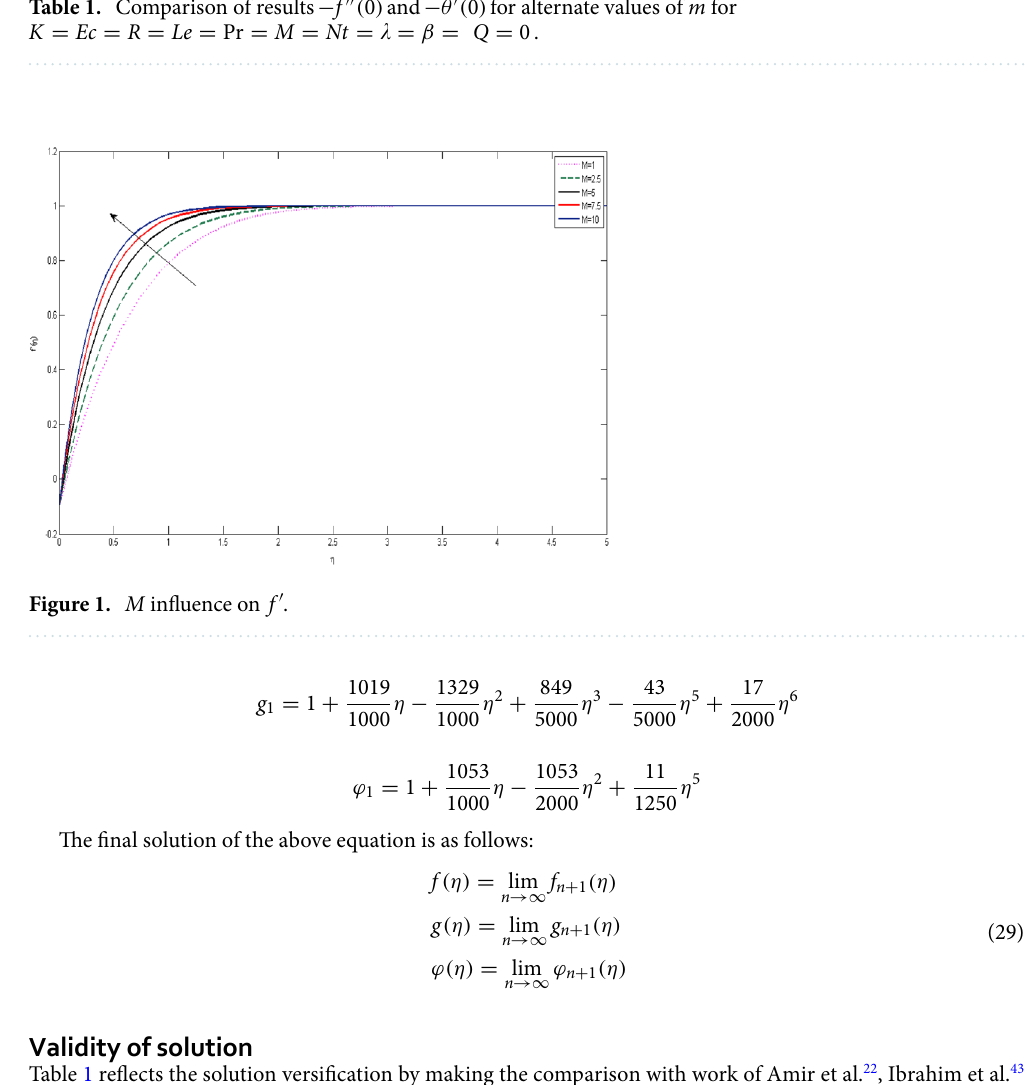
Table 1. Comparison of results − f ′′ ( 0 ) and − θ ′ ( 0 ) for alternate values of m for